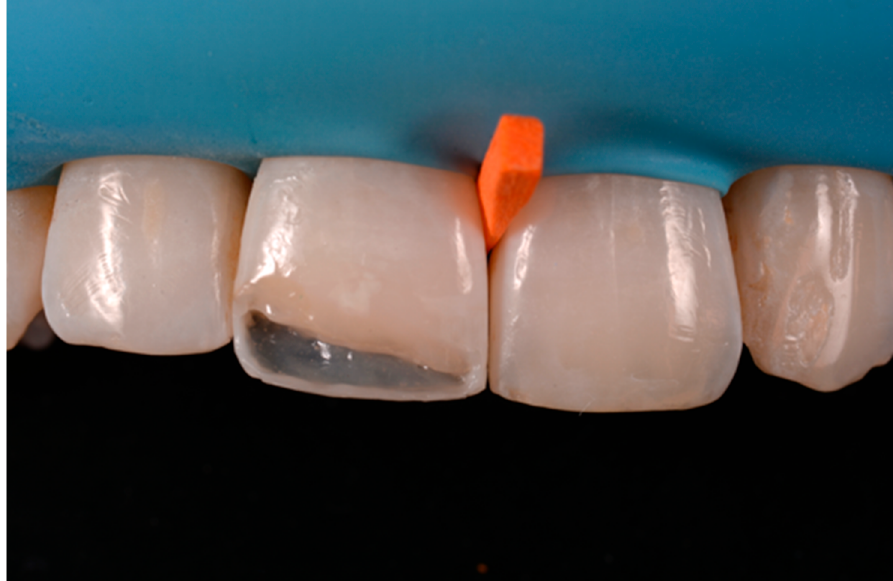
Figure 53. After frame is modified, silane coupling agent and adhesive is applied before dentinal body layering as described in Section 2.1.2.